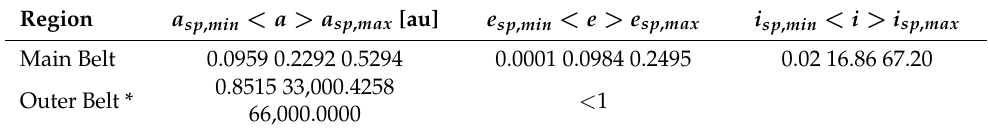
Table 4. The boundaries of the asteroid belts: maximum, minimum and average of the semi-proper elements. The values for the semi-major axis of the outer asteroid belt are biased by the input limits (maximum semi-major axis of the initial sample is a = 1.0 au). The asterisk indicates that the maximum bound of the outer belt is determined from the initial conditions, but not computed.